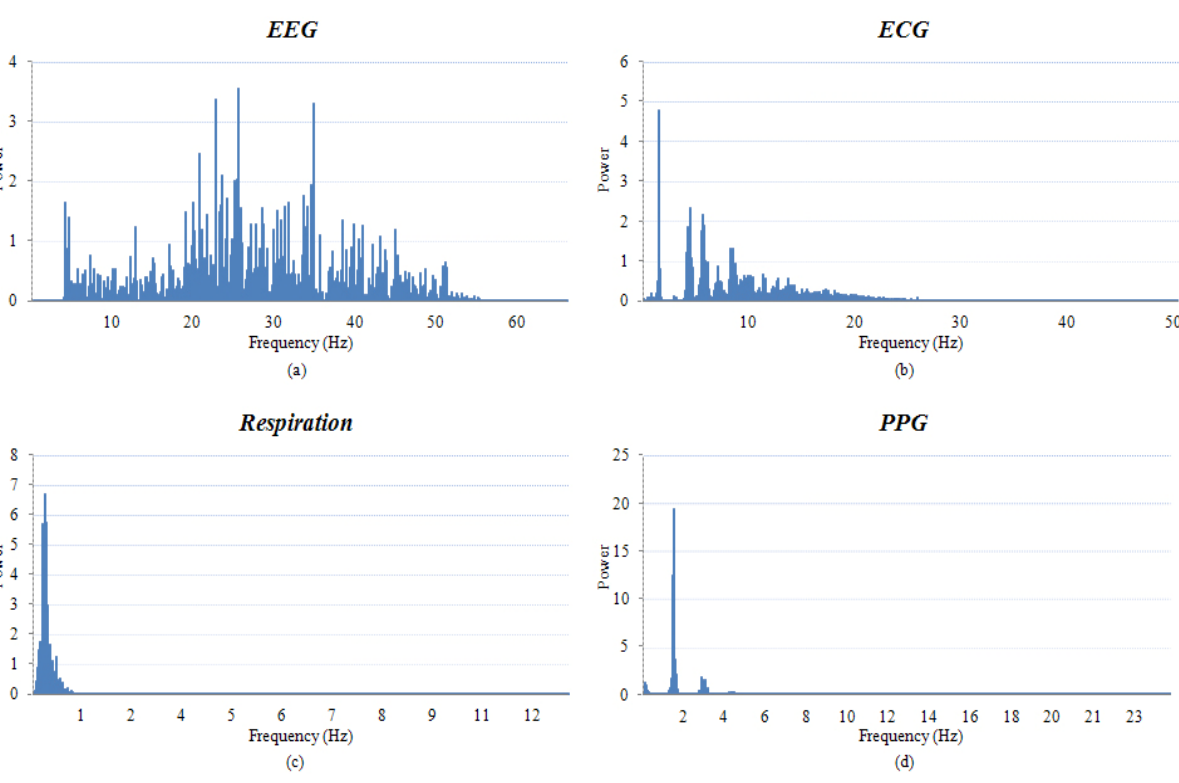
Figure 10. Fast Fourier-transform results ( a ) EEG frequency contents; ( b ) ECG frequency contents; ( c ) Respiration frequency contents; and ( d ) PPG frequency